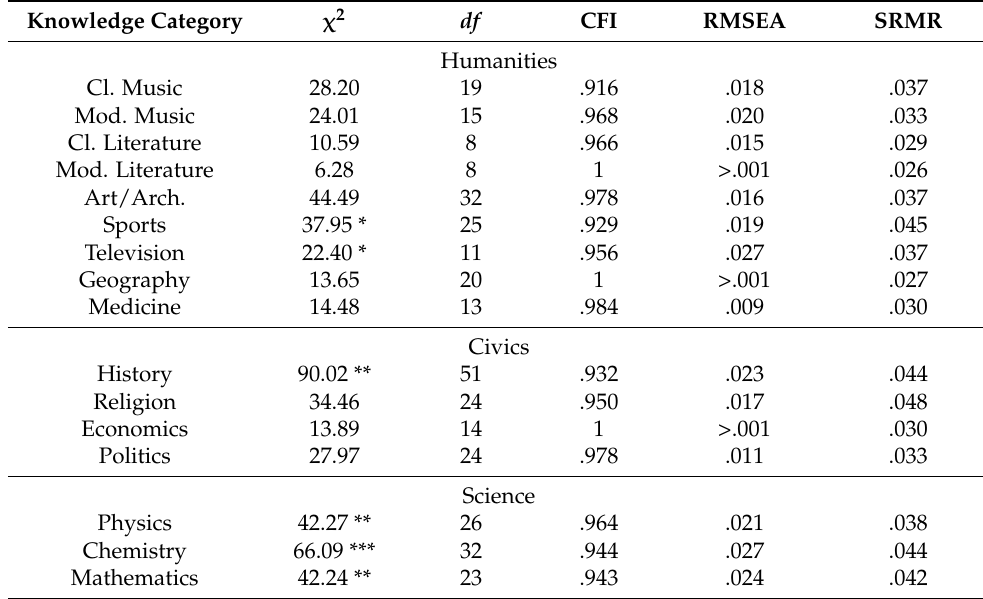
Table 4. CFA Results for Knowledge Categories (Total Sample).